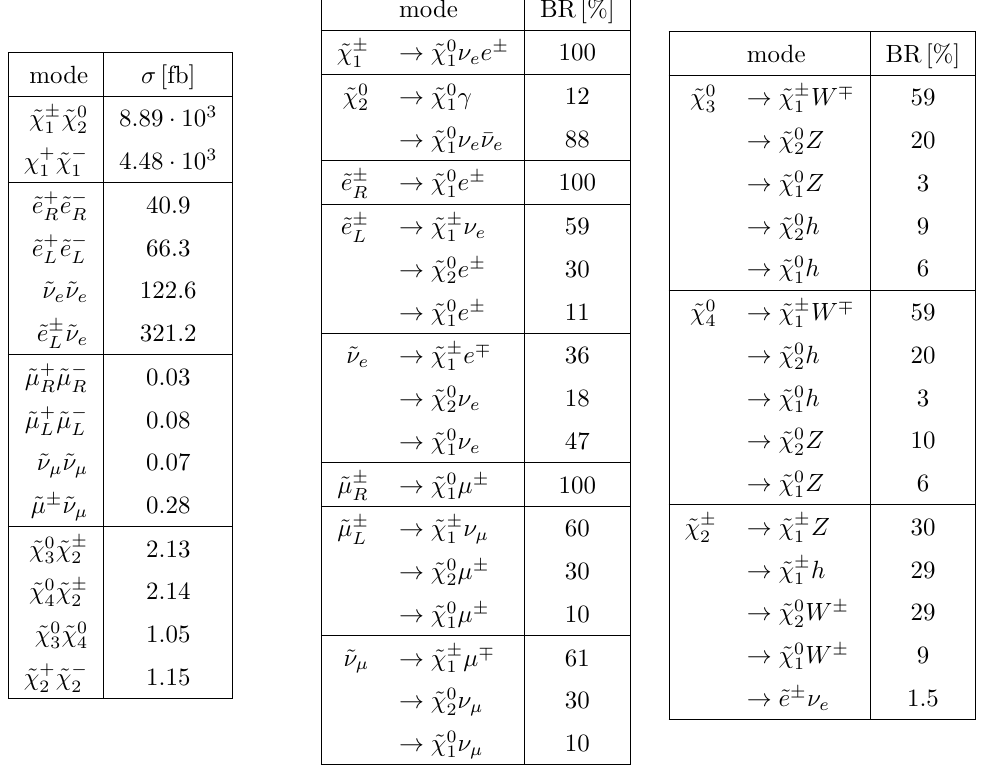
Table 4 . The NLO production cross-sections at the 13 TeV LHC and branching ratios of light sparticles for